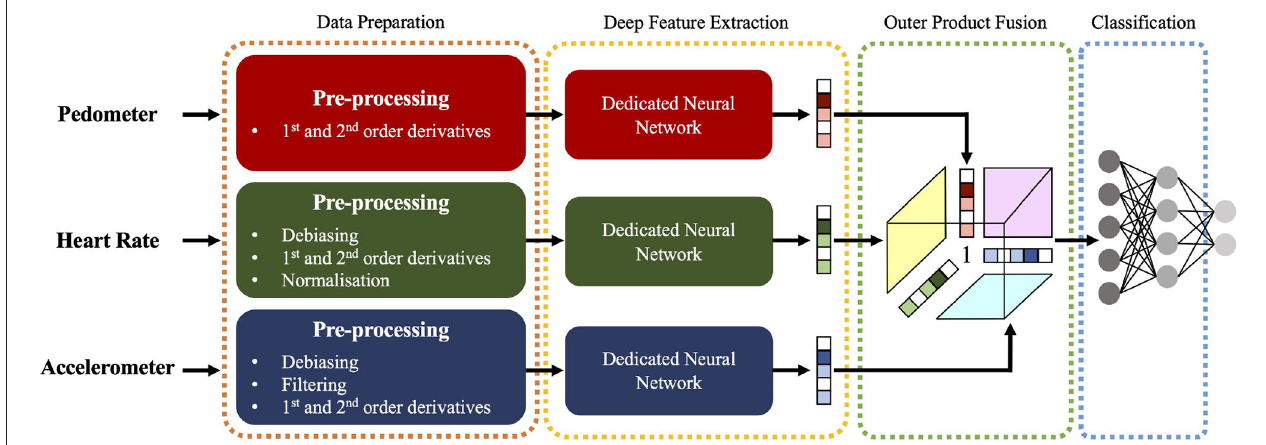
FIGURE 2 | Block diagram illustrating the system implemented, which receives the measurements from the pedometer, heart rate, and accelerometer modalities, and outputs the probability of the current sample to belong to the different activities